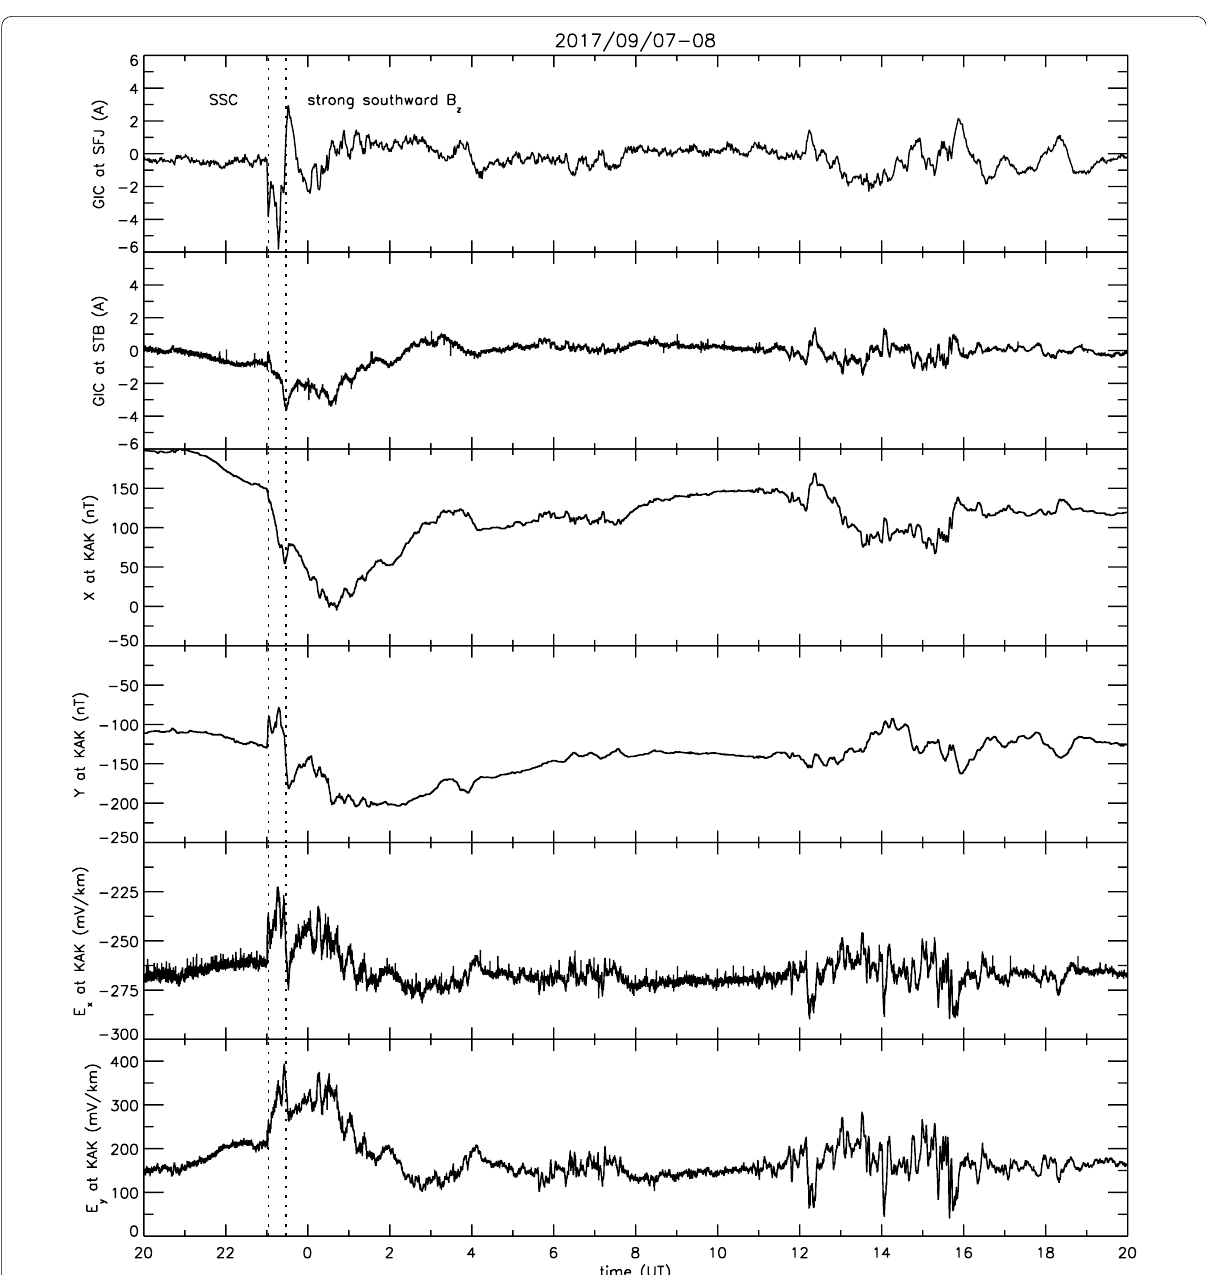
Fig. 10 One-minute GIC data at SFJ, 0.1-s GIC data at STB, and X- and Y-components of geomagnetic and geoelectric fields at KAK of the 7–8 September 2017 geomagnetic storm. The two dotted vertical lines show the time of the SSC and the start of the strong southward B z shown in Fig.